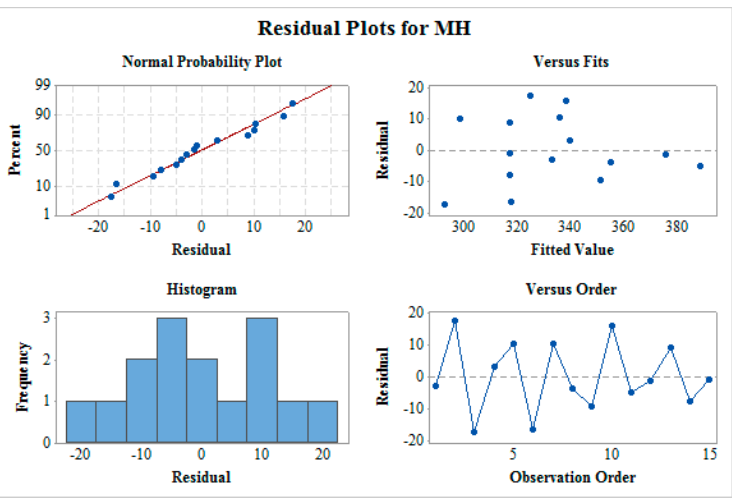
Figure 5. Residual plot for microhardness (MH). Table 4. Analysis of variance (ANOVA) for MRR, SR and microhardness.